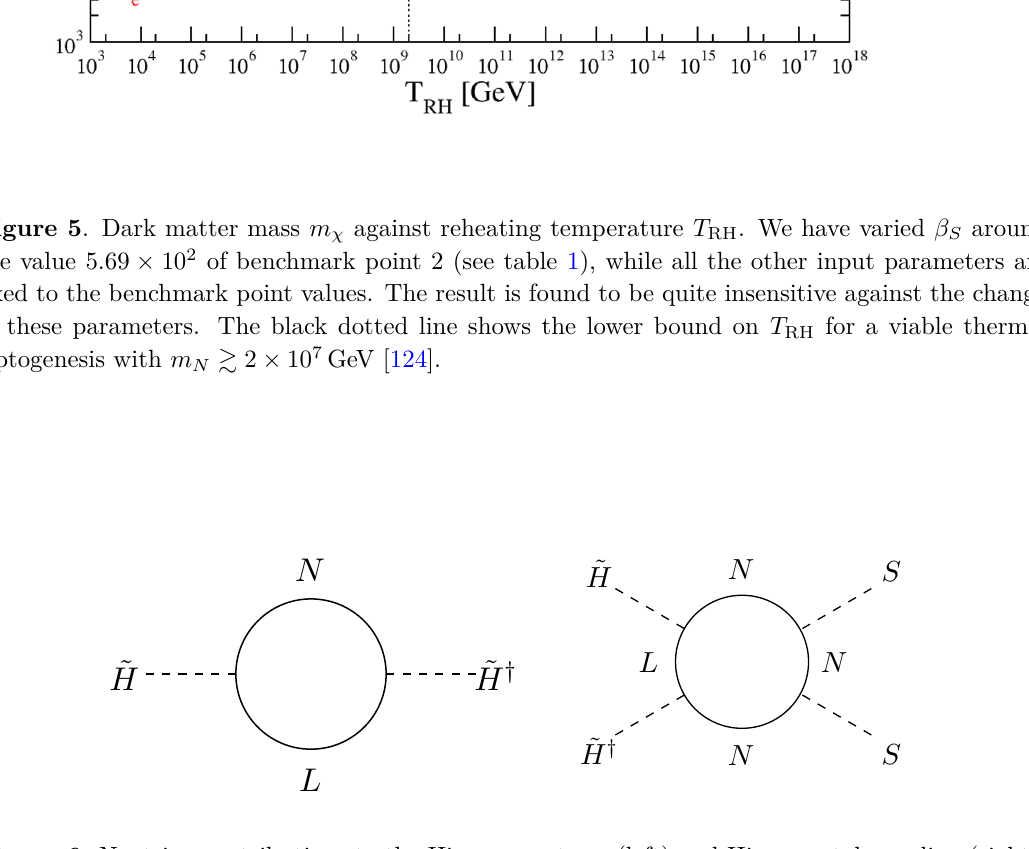
Figure 6 . Neutrino contributions to the Higgs mass term (left) and Higgs portal coupling